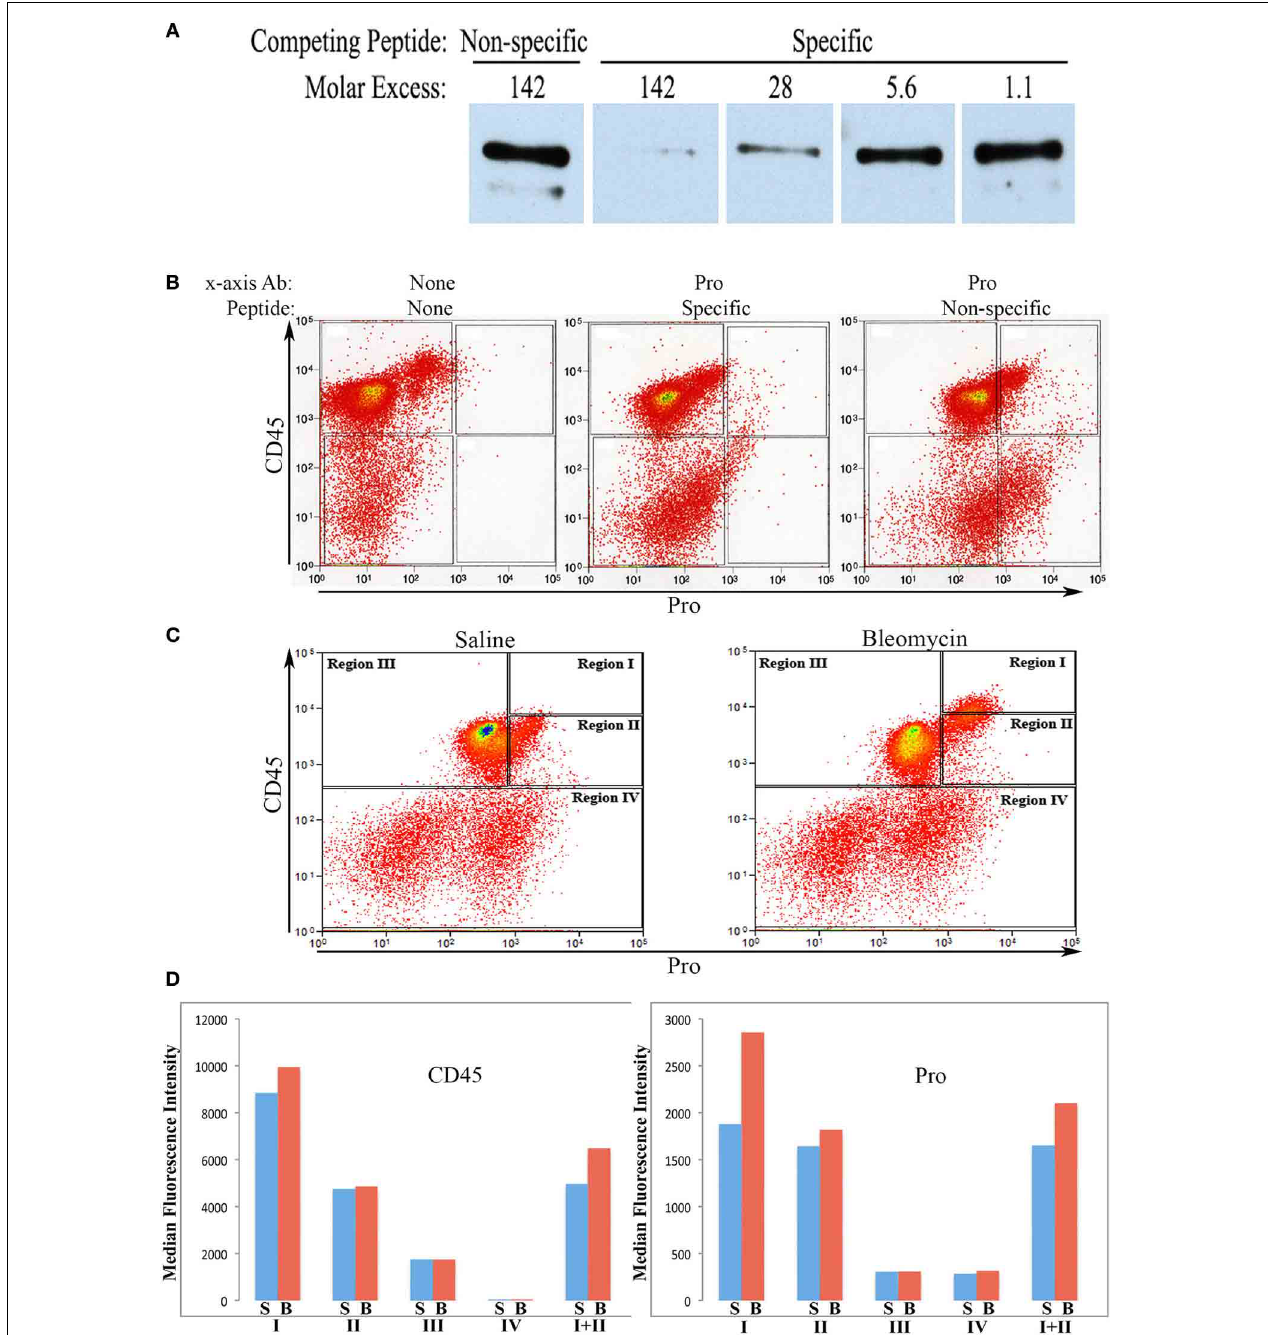
FIGURE 1 | Characterization of Pro by Western Blot and use in flow cytometry.(A) HumanlungfibroblastculturesupernatantwasWesternblotted using Pro (0.2 μ g/ml) competed with Non-specific peptide (immunogenic peptide for Telo, 0.4 μ g/ml = 142-fold molar excess), with Specific peptide (immunogenic peptide for Pro, 0.4 μ g/ml = 142-fold molar excess), or with serial 5-fold dilutions of Specific peptide. The prominent polypeptide detected is full-length 180kD procollagen I α 1. The minor, slightly smaller polypeptide lacks the N-terminal propeptide. (B) Total lung cells from a bleomycin-treated mouse sacrificed 28 days after initiation of treatment were immunolabeled for CD45 and, as indicated, with no additional antibody, with Pro competed with specific peptide (142-fold molar excess), and with Pro competed with non-specific peptide (142-fold molar excess). Scatter plots are presented with